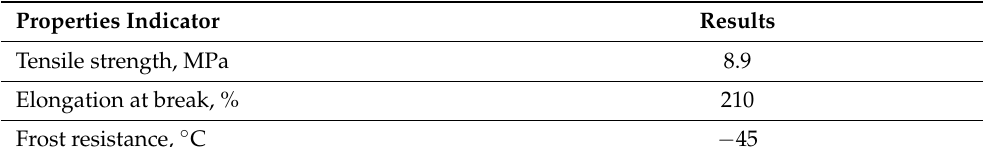
Table 1. Physical and mechanical properties of recycled plastics. Properties Indicator